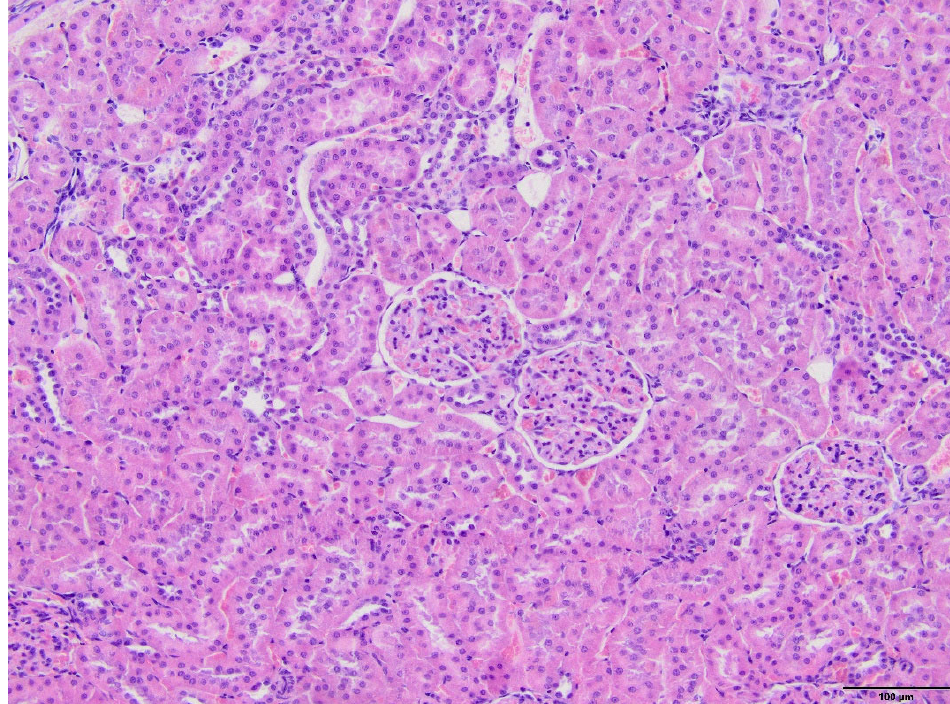
Figure 7. Kidney of rat on regular diet (RD). All structural elements of the kidney are seen: three glomeruli without structural abnormalities, normal tubules, interstitium and blood vessels. (HE, magnification 20×). Table 4. Metabolic characteristics of rats on fructose ‐ rich diet (F10 + F60) developing stones versus animals without kidney stones.